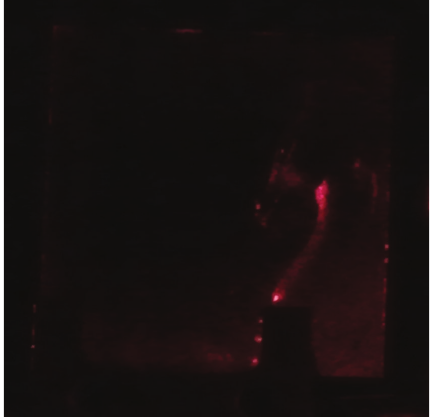
Figure 4: The reconstructed virtual image is